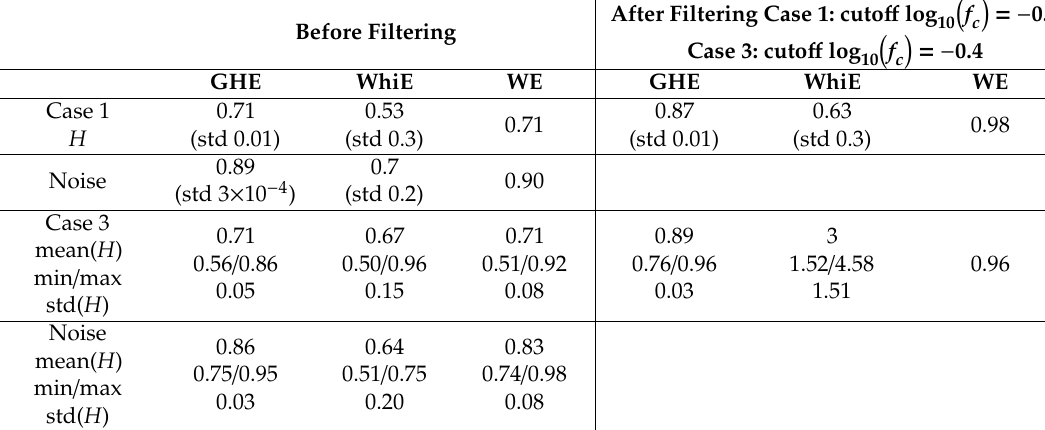
Table 2. Estimation of the Hurst parameters from the residuals for case 1 and case 3, with the three estimators under consideration. We additionally give the standard deviation of the estimation, when available. Additional angle noise, H ref = 0.9.